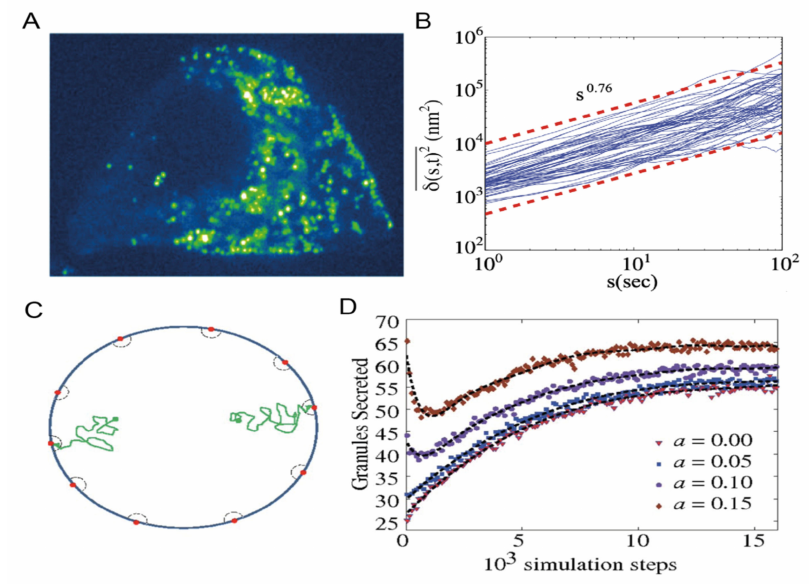
Figure 8. Characterization of ISGs mode of motion. ( A ) Typical confocal fluorescence image of syncolin-EGFP–labeled insulin granules in live MIN6 cells. ( B ) Time-averaged mean square dis- placement (TA-MSD) as a function of lag time. Blue lines are for individual trajectories of length t = 200 s, and the red dashed lines show an exponent of α = 0.76. ( C ) Simulation system scheme used to test biphasic secretion can be compatible with subordinated random walk. ( D ) Secretion flux of simulated granules. Adapted from Tabei et al.